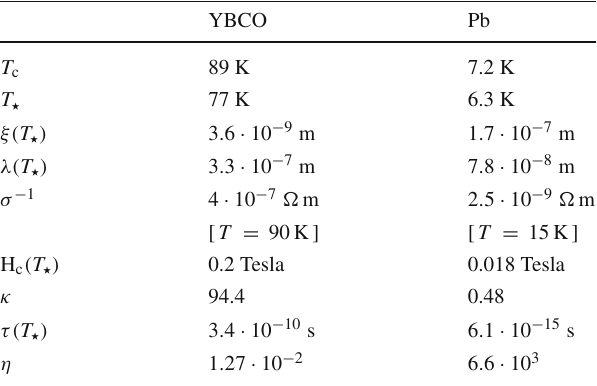
Fig. 5 The gravitational field E g / g (cid:23) as a function of the normalized time in the case of Pb, for different values of L and x = 4 λ . The maximum of the shielding effect is evident Table 1 YBCO vs.